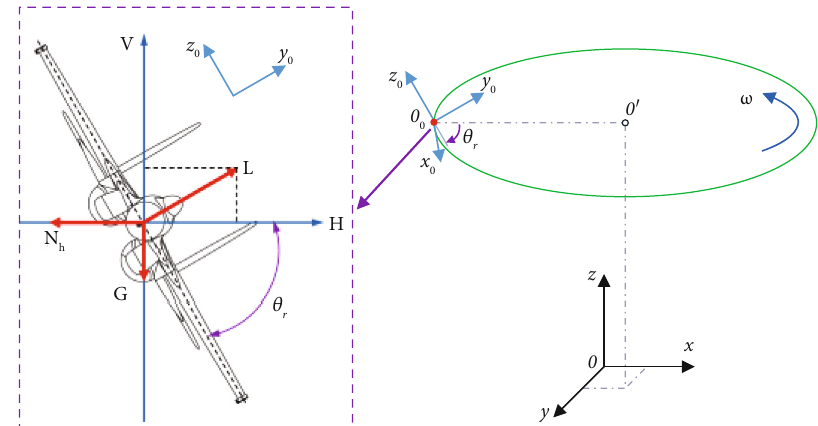
Figure 5: Sketch of horizontal maneuvering.